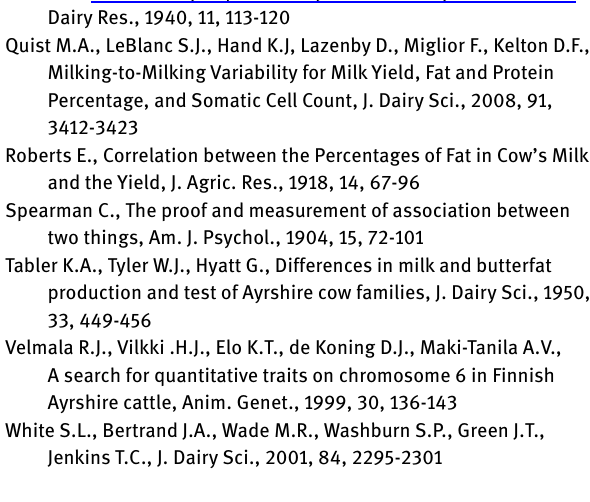
Tabler K.A., Tyler W.J., Hyatt G., Differences in milk and